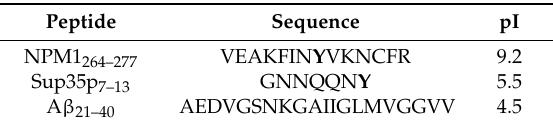
Figure 1. Chemical structures of Pt(II) complexes used in this work.